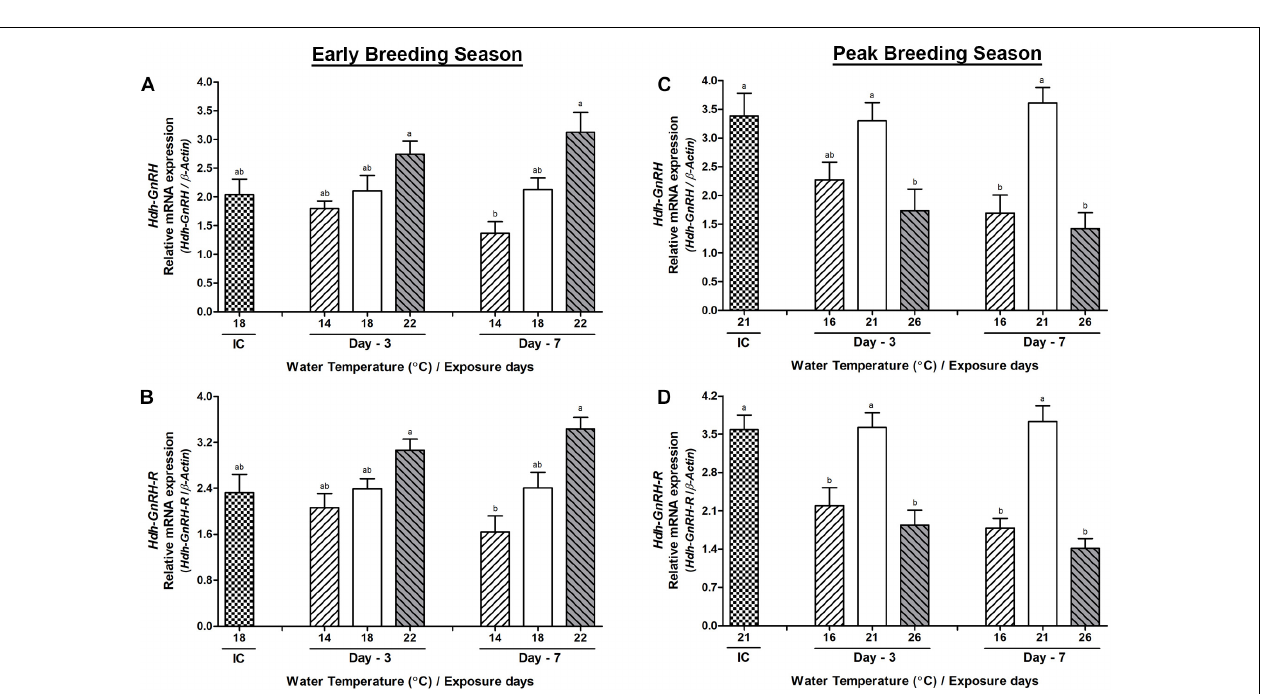
FIGURE 4 | Changes in the relative mRNA expression of Hdh-GnRH (A,C) and Hdh-GnRH-R (B,D) in the pleuropedal ganglion (PPG) of male Pacific abalone during early and peak breeding seasons after exposure to thermal stress for 7 days. Before exposure to the target temperature of thermal stress, abalone were sampled to obtain reference values that served as initial control (IC). Values represent the mean ± SD ( n = 10). Different letters on the bar indicate significant differences among different temperature groups ( p < 0.05).